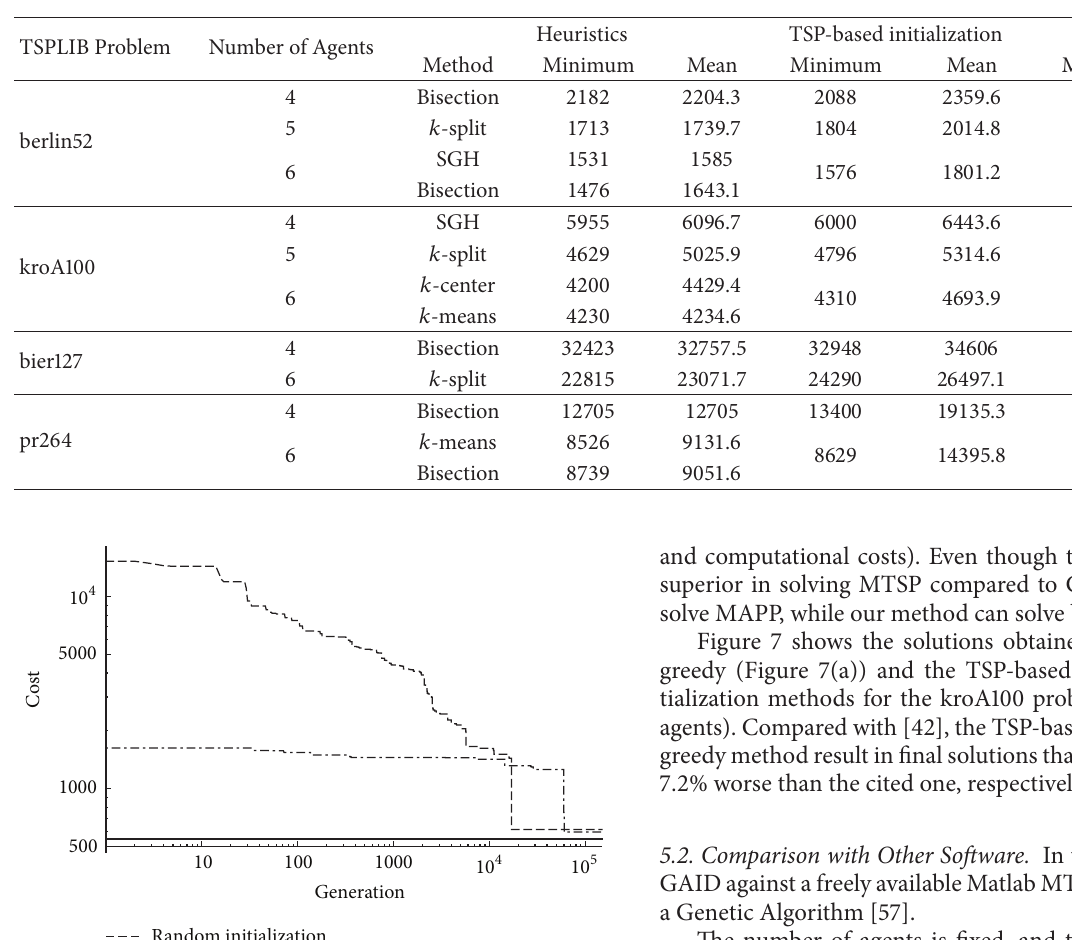
Table 3: Heuristics comparison for 100 simulations using the TSP-based initialization.